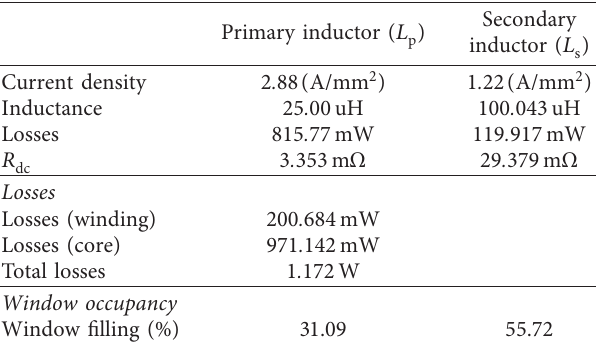
Table 3: Ansys Maxwell analysis report: coupled inductor per- formance results